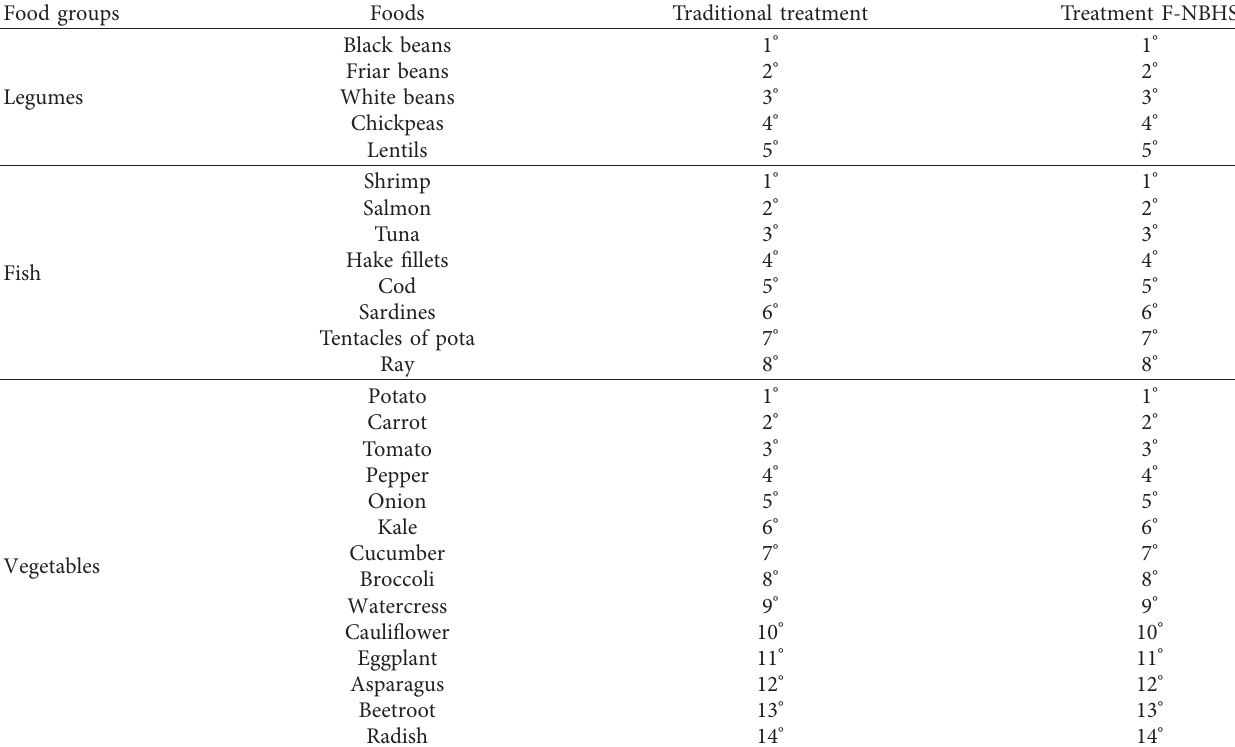
Table 10: Ranking of food preferences divided by food groups according to each scale